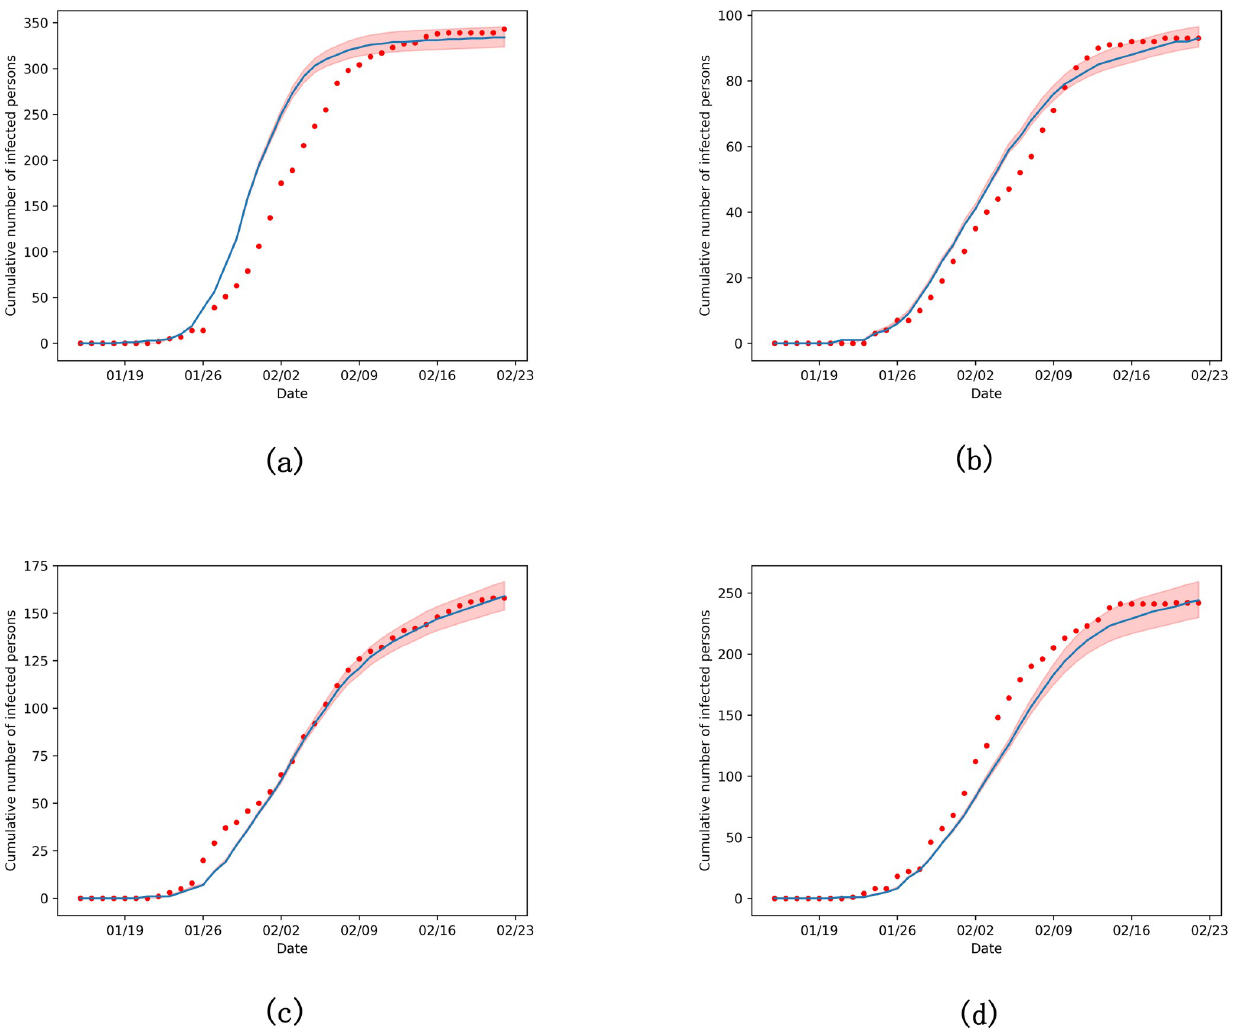
Fig 3. The cumulative number of infected persons in the cities of China. (a) Guangzhou, (b) Nanjing, (c) Zhengzhou, (d) Changsha. Actual data are fitted onto the curve (red